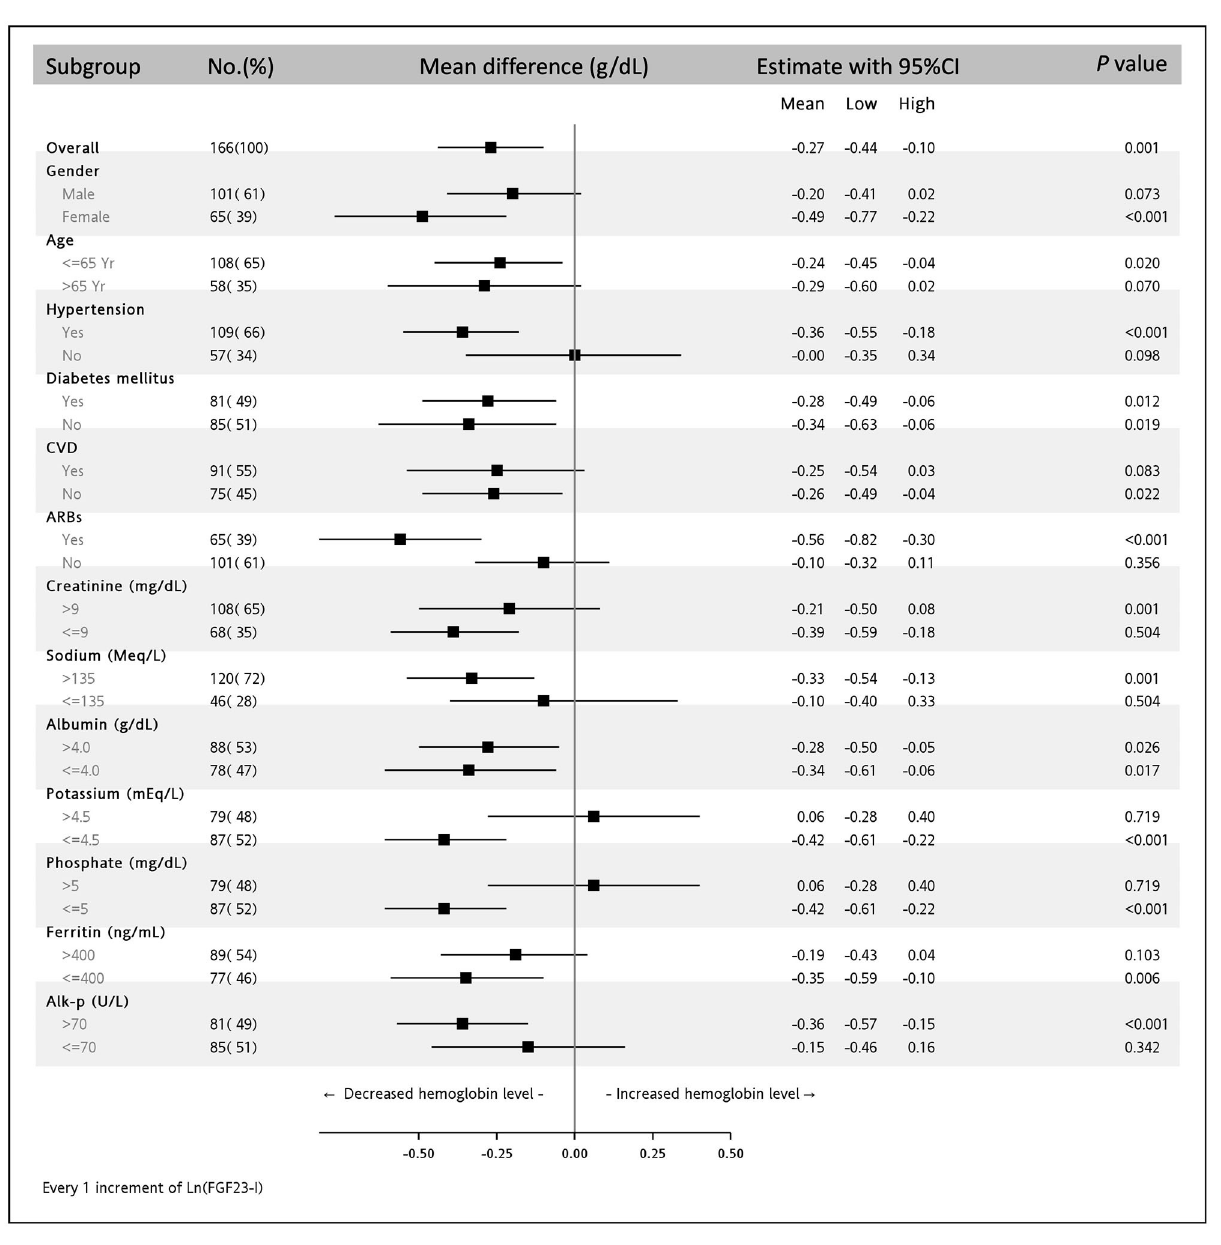
FIGURE3 Subgroup analysis of the association between ln(iFGF23) and serum hemoglobin level in the multivariable adjusting model. The parsimonious adjusting model is Model 3 in Table